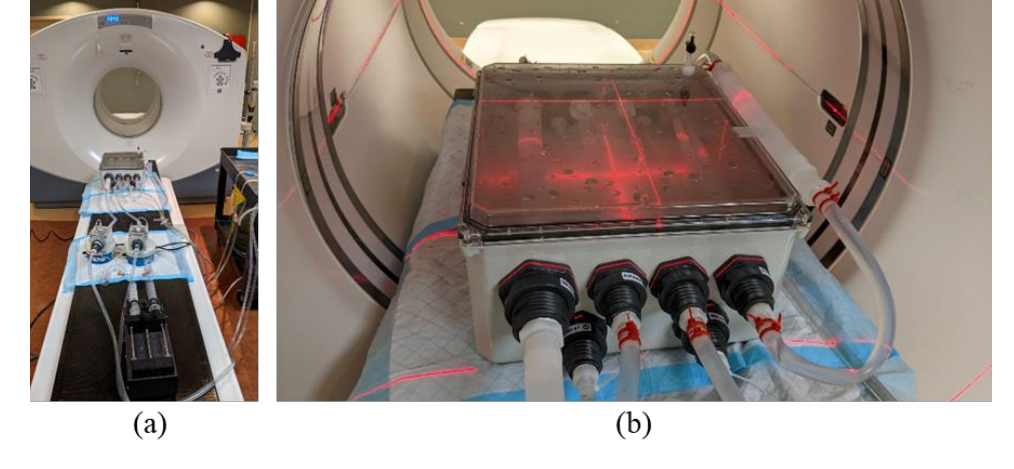
Figure 4. The AIF Correction factor validation phantom. ( a ) The four tubes inside the phantom shell decreasing in size from 1” to 1/2”, 3/8” and finally 1/4” followed by the buffer tube at the right side. ( b ) The injection setup on the PET-CT couch. Scanning is performed in the middle of the tubes over a single (14.7 cm) PET field of view. This phantom contained a water-tight shell as well as a set of 4 tubes of decreasing diameter from 1” (25.4 mm) to 1/4” (6.35 mm). The choice of these tube sizes was to resemble the size of descending aorta (1”) to that of the internal iliac arteries [5] which are typically used as the AIF for numerous perfusion sites including cervix, prostate and rectum. The 1/4” tube then left the phantom and was diluted with a buffer compartment before re-entering the phantom to simulate venous flow from the iliac vein. In addition to the input function tubes, a flow system was attached to fill and inject contrast/radioisotope into the background compartment. Flow @ 10 mL/s was perfused through the tubes using a peristaltic pump (Fisher Scientific, Hampton, NH, USA) with control valves allowing for flow through the tubes, background or both simultaneously. 2.3. Experimental Setup and Validation in CT To establish reference ‘input function’ curves with consistent peak activity and AUC, dynamic contrast enhanced (DCE)-CT Scanning was performed with a 1 s Gantry rotation 120 kV, 350 mA every 6 s for 4 min on a GE Discovery 610 PET-CT system. The phantom was set up on the CT couch as shown in Figure 4. A Harvard Syringe Injection Pump was attached to the system and connected to each of the two mixing chambers, one for the input function and one for background. A 60 cc syringe was loaded with a 1:1 mixture of 370 mgI/mL Iodine based contrast agent and water. The flow rate through the system was set to 600 mL/min. Injection of the contrast agent occurred at 0.5 mL/s for 50 s. A replicate experiment was performed to produce error bars (range of measurements n = 2). 2.4. PET-CT Experiments Every attempt was made to ensure that the PET-CT protocol generated identical time activity curves to the DCE-CT scan. The same setup was utilized for the PET-CT experiments with the only difference being that instead of a 1:1 mix of 370 mgI/mL contrast, we used 88 MBq 18 F-FDG diluted in 100 cc water. From the 18 F-FDG dilution, 60 cc (53 MBq) was loaded into a syringe to be injected @ 0.5 mL/s for 50 s as in DCE-CT. For